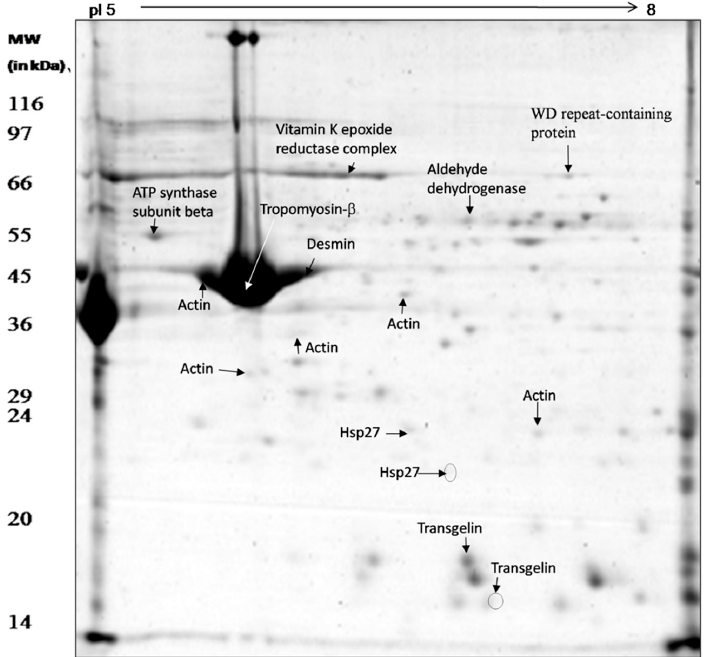
Figure 3. Proteome map of C. hircus mesenteric artery vessel wall proteins showing the protein spots identified by mass spectrometry (LC-MS/MS and MALDI TOF/MS). Table 3. Protein spots identified by LC-MS/MS in mesenteric artery proteomes. ↑ indicates upregu- lation of the protein spot. Fold change value was calculated by using the 2D gel image analysis software PD Quest (Bio-Rad) version 7.20. A value of p < 0.05 was considered to be statistically sig- nificant.